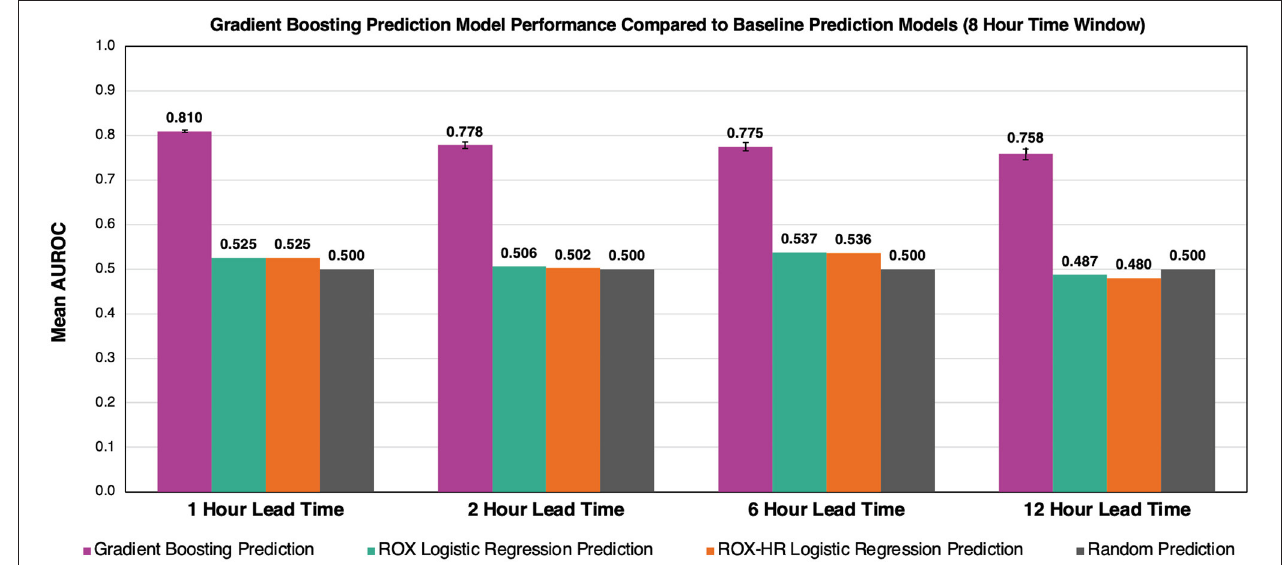
FIGURE 7 | Comparison of gradient boosting model to ROX and ROX-HR with respect to AUROC performance. At a time window of 8h, our model outperforms the ROX and ROX-HR logistic regression baselines at lead times of 1, 2, 6, and 12h. Error bars represent 95% confidence intervals between our five cross-validation folds. Error bars for ROX and ROX-HR predictions are not visible and are zero up to three decimals.